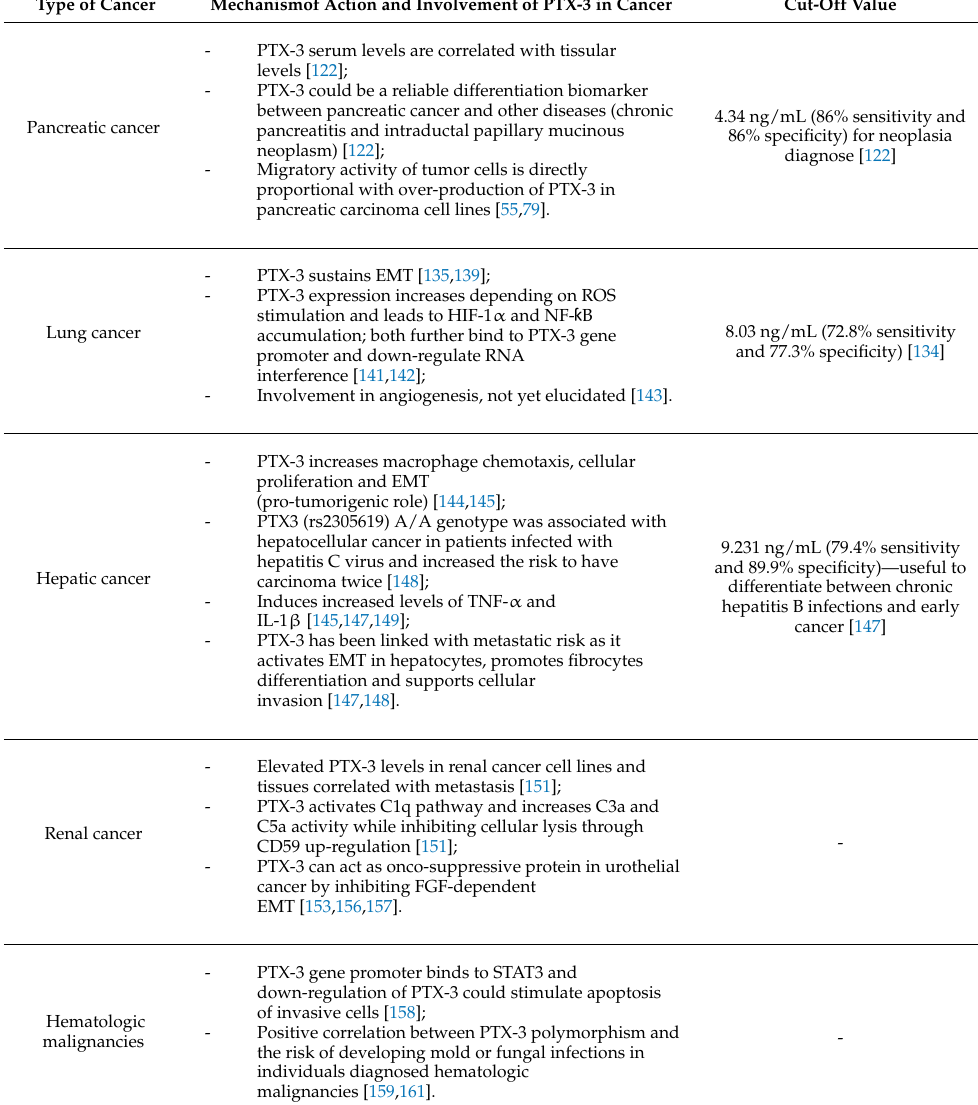
Table 1. Cont. Type of